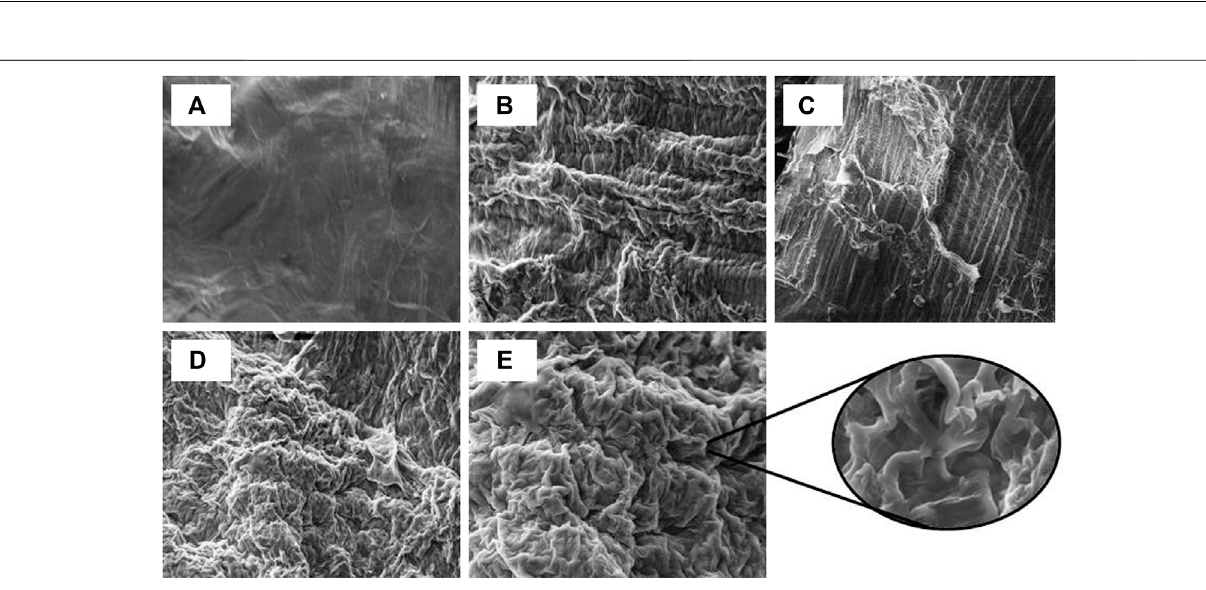
Frontiers in Energy Research |